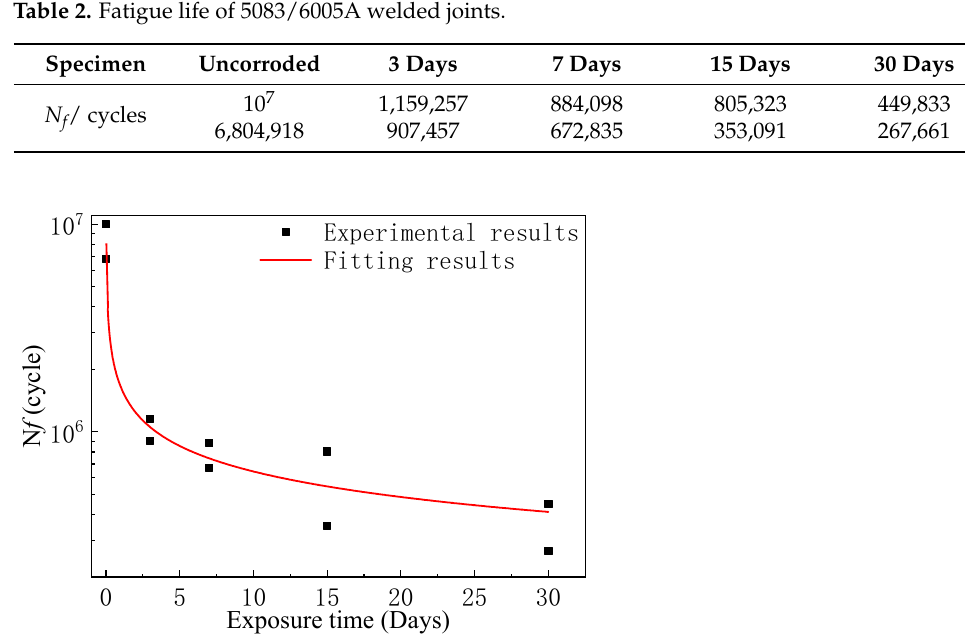
Figure 3. The effect of corrosion time on the fatigue life, obtained by fitting the results in Table